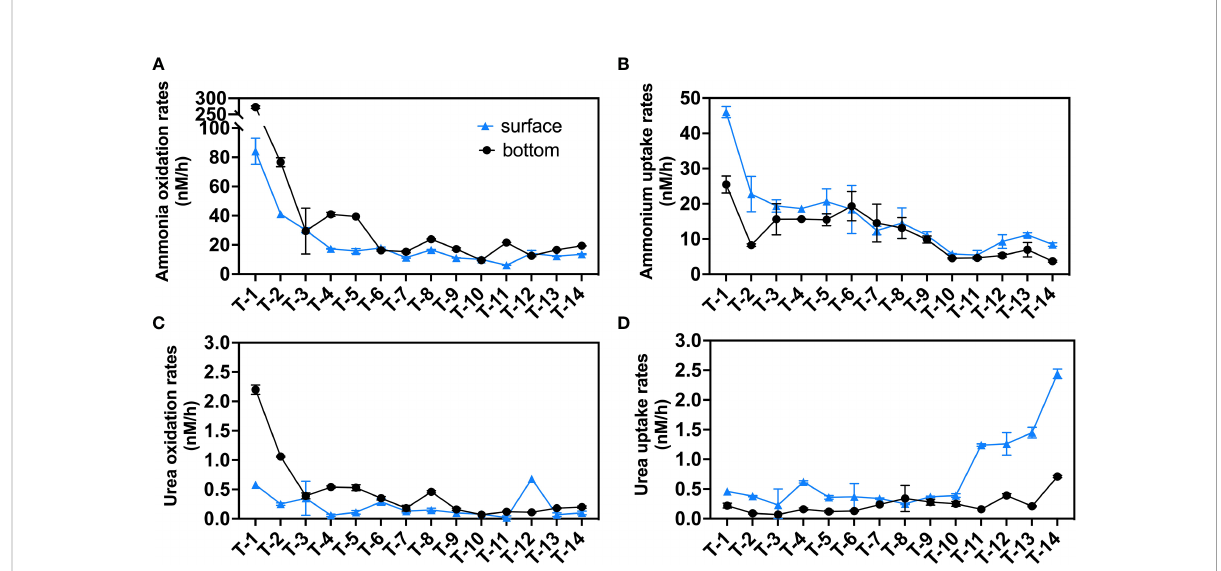
FIGURE 3 N transformation rates (nM/h) in the sampling stations: (A) ammonia oxidation rates; (B) ammonium uptake rates; (C) urea oxidation rates; (D) urea uptake rates. Blue triangles indicate surface rates, black circles indicate bottom rates and the error bars represent the standard deviation of the two biological